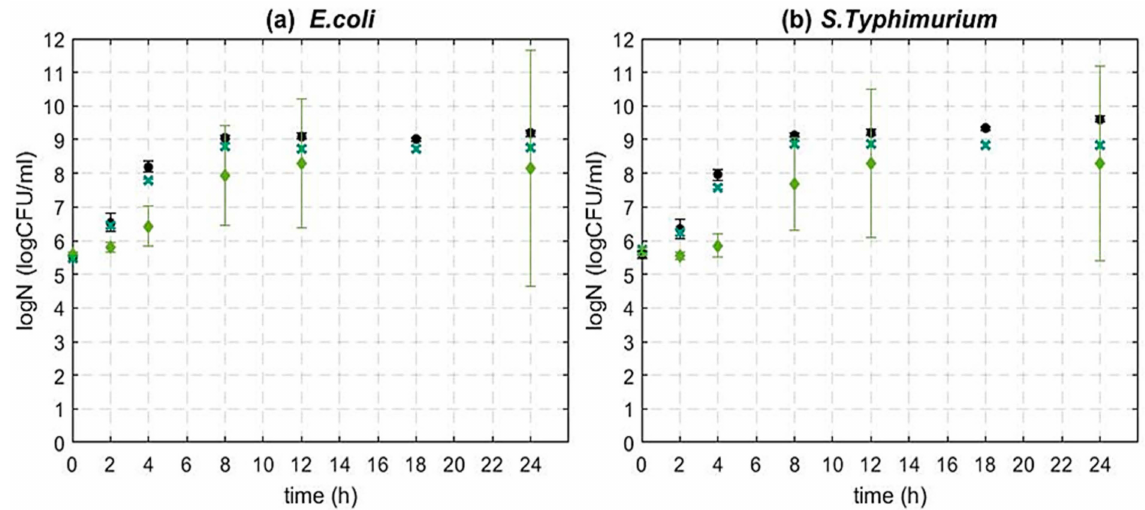
Figure 3. Inactivation dynamics of ( a ) E. coli MG1655 and ( b ) S . Typhimurium ATCC 14028 stationary phase cells at initial inoculum concentration 10 5 CFU/mL. In both plots, ( • ) control ( w / o GSE), ( × ) 1% GSE and ( (cid:7) ) 4% GSE. Each time point represents the average of at least four independent experiments with significant difference ( p < 0.05) and three technical replicates per experiment. Error bars show standard